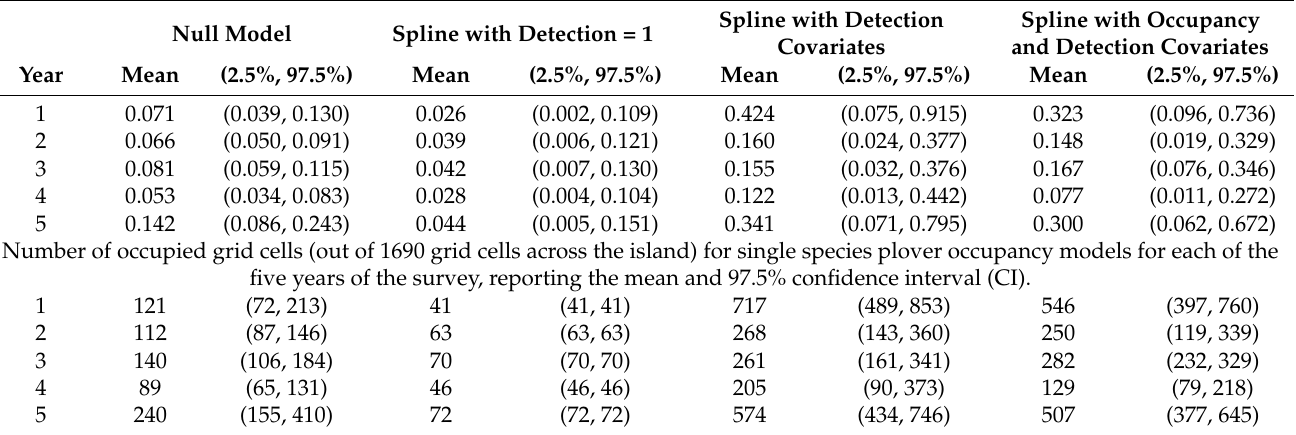
Table 3. Piping plover model estimates for occupancy, reporting the mean and 97.5% confidence interval (CI) for each of the four models across the five years.